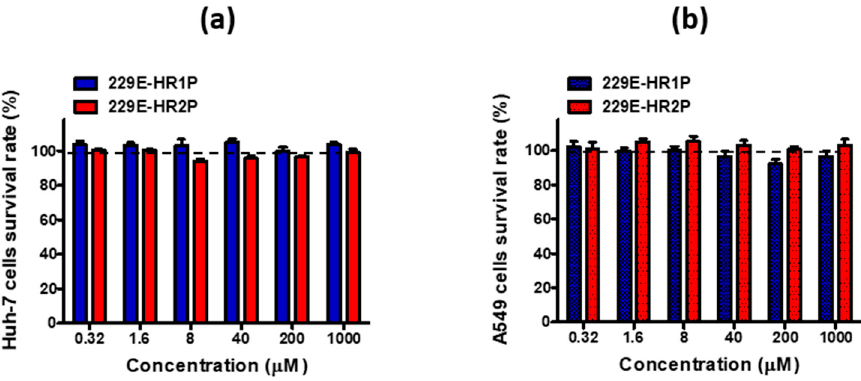
Figure 6. Cytotoxicity of 229E-HR1P and 229E-HR2P. ( a ) Cytotoxicity of 229E-HR1P and 229E-HR2P to Huh-7 cells; ( b ) Cytotoxicity of 229E-HR1P and 229E-HR2P to A549 cells. Data are means ± SD of triplicate samples from a representative experiment.